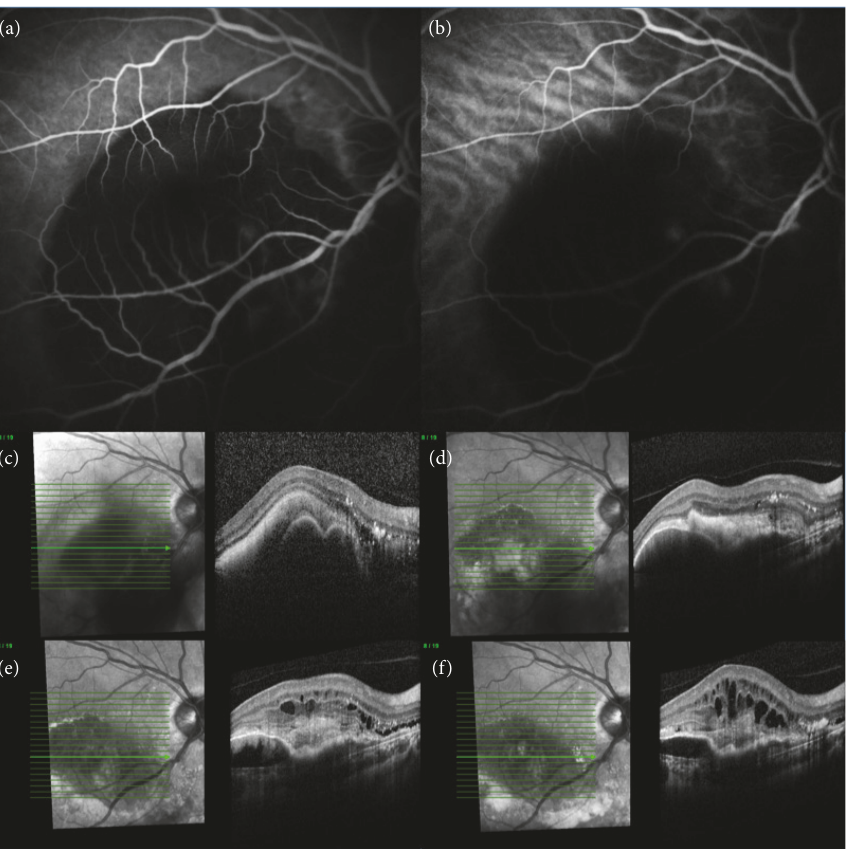
Figure 1: Retinal angiography using fluorescein (a) and indocyanine green (b) of the patient’s right eye. The polypoidal lesions are difficult to visualize due to the massive subretinal hemorrhage. Optical coherence tomography at (c) baseline (BCVA: 68 ETDRS letters, Snellen 6/15), (d) 3 months (BCVA: 64 ETDRS letters, Snellen 6/19), (e) 6 months (BCVA: 55 ETDRS letters, Snellen 6/24), and (f) 9 months follow-up (BCVA: 55 ETDRS letters, Snellen 6/24) shows a gradual development of subretinal fibrosis and intraretinal